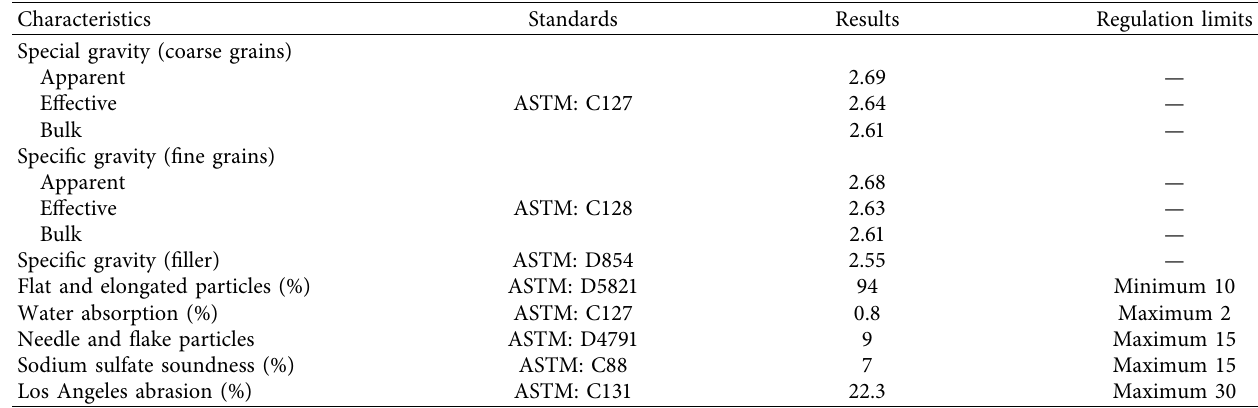
Table 1: The physical characteristics of aggregate.